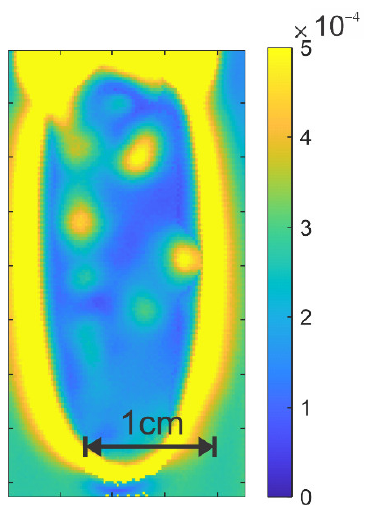
Figure 9. Relative birefringence map of the sample in Figure 8. Note the concentration of stress (indicated by relatively large birefringence) at points of inclusions. For specific inclusions, there is a corresponding significant change in the local stress direction (not shown).